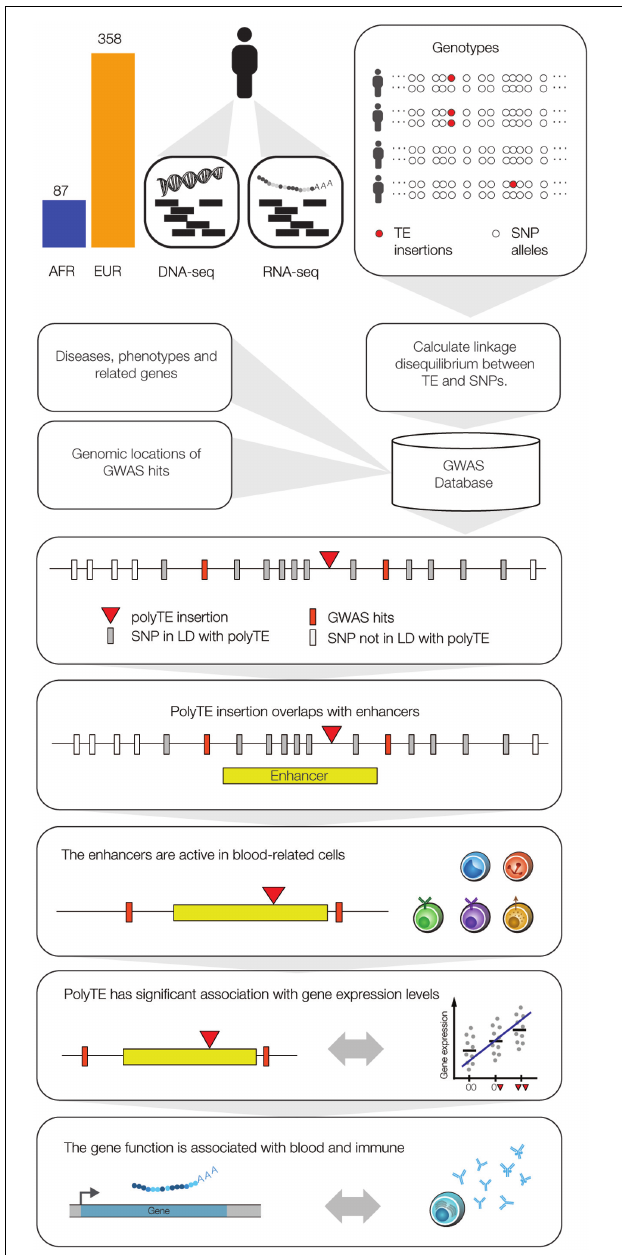
FIGURE 1 | Integrative data analysis used to screen for polyTE disease-associations. Matched DNA-seq and RNA-seq samples were analyzed for 445 individuals, 87 Africans (AFR – blue) and 358 Europeans (EUR – orange). Genome-wide genotypes were characterized for polyTE insertions (presence/absence) and SNPs, and the linkage disequilibrium (LD) structure for polyTE insertions and SNP alleles was characterized for all samples. The NHGRI-EBI GWAS database was mined to extract SNP disease-associations and related information on diseases, phenotypes, genes and SNP genomic locations. A series of filters was applied to screen for a set of high-confidence polyTE disease-associations. PolyTEs were evaluated for: (1) minor allele frequency (MAF), (2) linkage to disease-associated SNPS (i.e., GWAS hits), (3) overlap with tissue-specific enhancers, (4) associations with gene expression, and (5) functional relevance for blood- and immune system-related